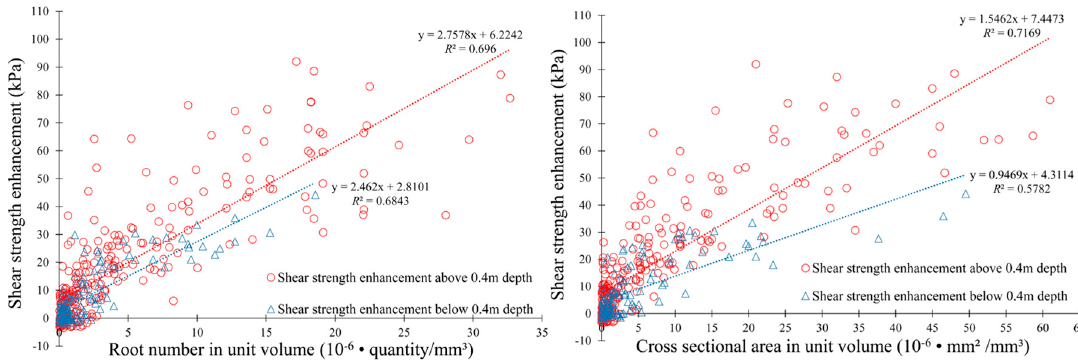
Figure 10. Best-fit curves of the shear strength enhancement with the number of roots and the root cross-sectional area per unit volume.